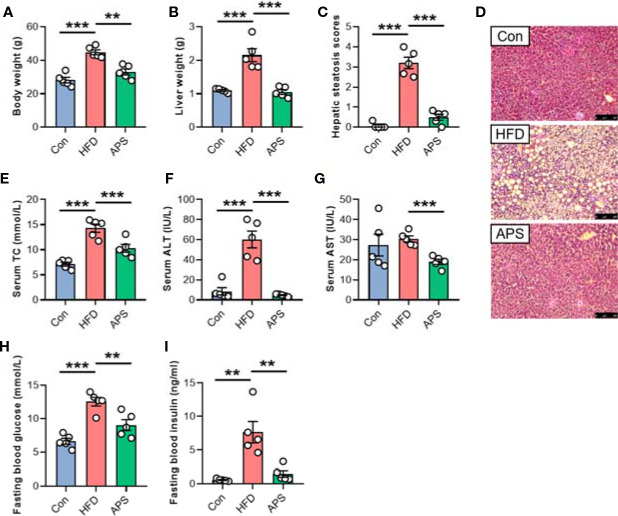
APS attenuates hepatic steatosis in HFD-fed mice. Male C57BL/6J mice (4-week-old) were treated with chow-diet (Con) or high-fat diet (HFD) with or without APS supplementation (8% APS in HFD) for 14 weeks. (A) Body weight. (B) Liver weight. (C) Hepatic steatosis scores. (D) Representative photomicrographs of liver tissue with H&E staining (magnification, ×200, 50 μm). (E) Serum total cholesterol (TC) level. (F) Serum alanine transaminase (ALT) level. (G) Serum aspartate aminotransferase (AST) level. (H) Fasting blood glucose level. (I) Fasting blood insulin level. n = 5, **p < 0.01, ***p < 0.001.